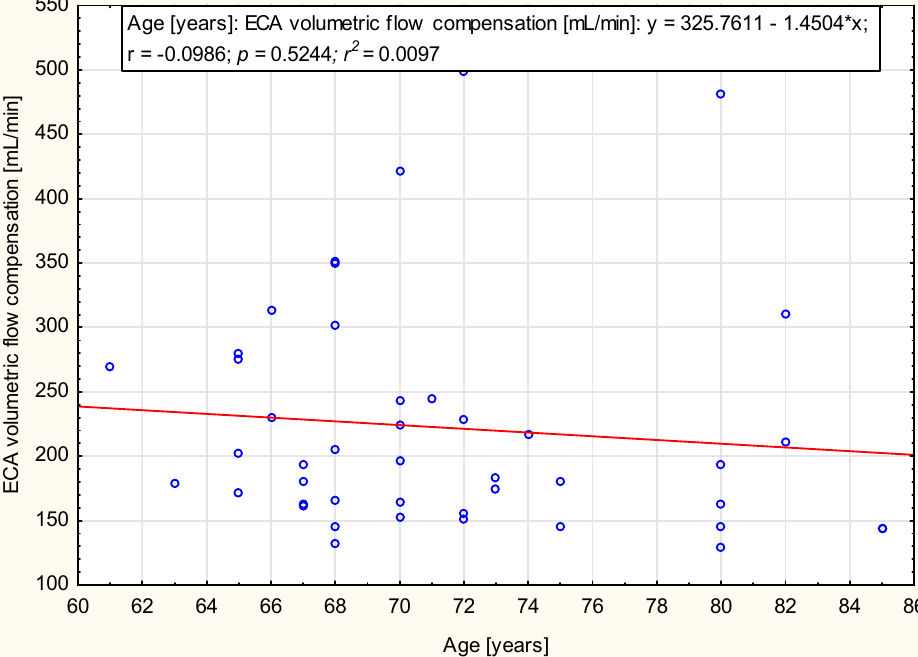
Figure 5. Scatter plot of the volumetric flow compensation in ICA and age (y = 316.0092 + 1.33778x). No correlation was observed ( p = 0.64).